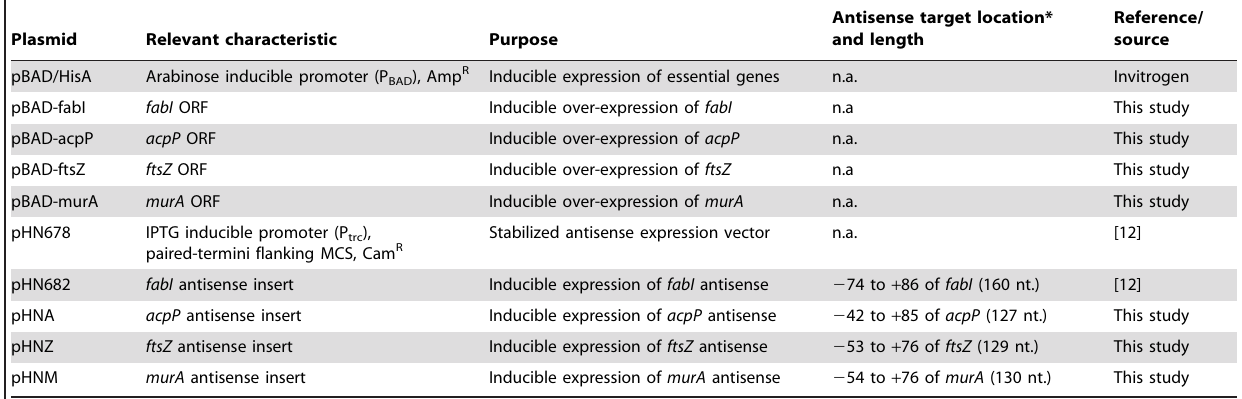
Table 2. Plasmids used in this study.